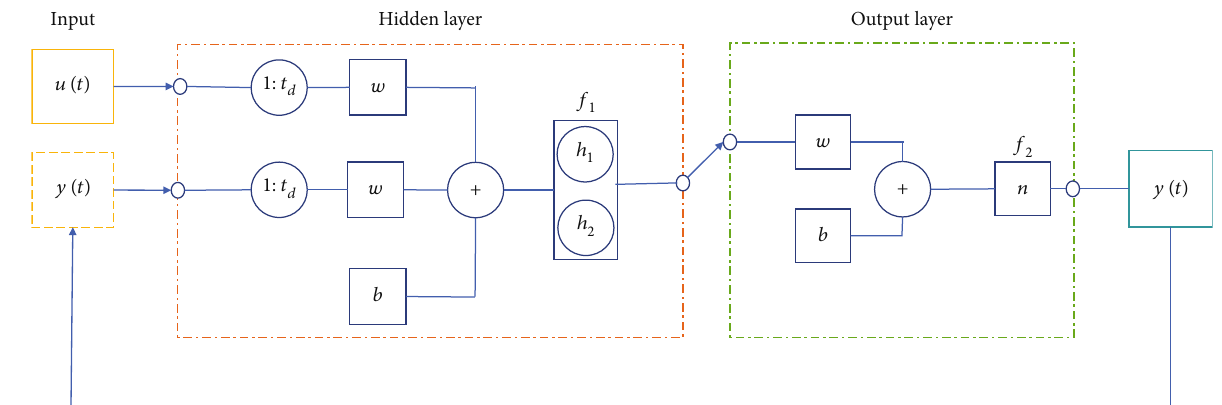
Figure 1: Architecture of the NARX